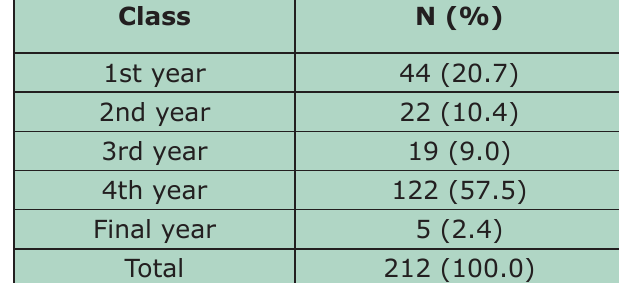
Table-I: Age Group of Participants.